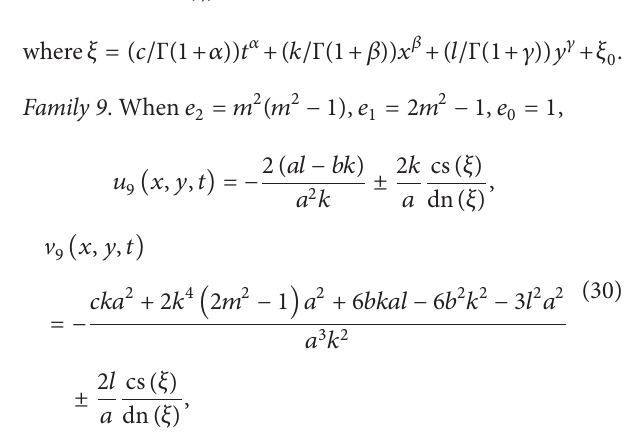
Figure 4: The periodic wave solution V 3 with 𝑒 1 = −1 , 𝑎 = 𝑏 = 𝑐 = 𝑘 = 1 = 1 , 𝑡 = 0.5 , and 𝛼 = 1/2 .